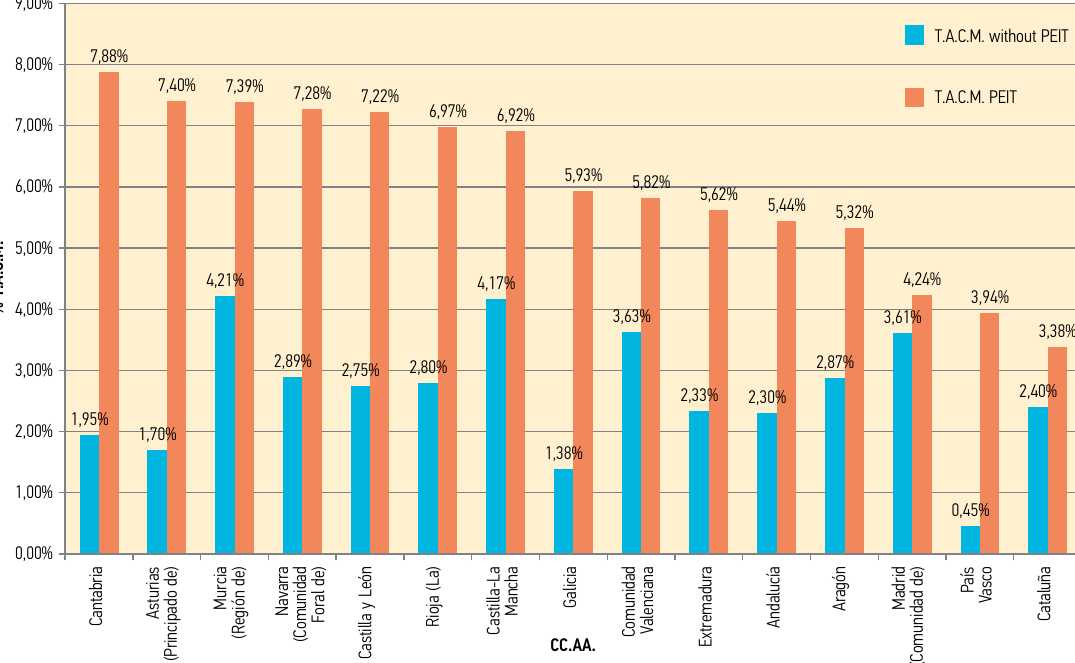
Fig. 8. Comparison of average annual accumulative rates of GDPmp at constant prices (notes: base 2005 = 100; period –